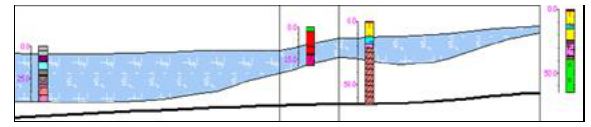
Figure-2 Cross section of aquifer along river Bandi